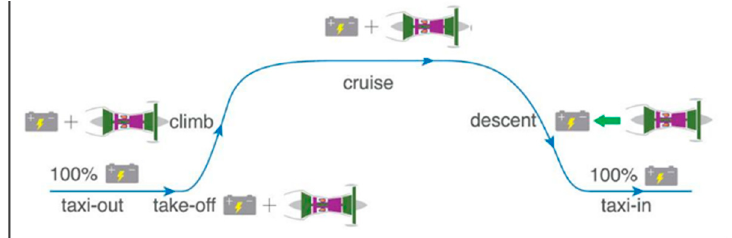
Figure 3. An example power management strategy adapted from [26]. During taxi-out/taxi-in phases, 100% electrical power is used, whereas during take-off, climb, and cruise conditions, battery and turbofan engine are used in parallel. The arrow on the mission profile indicates different flight stages.